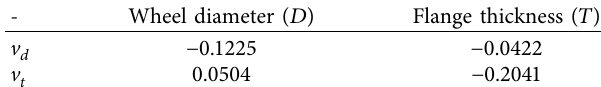
Table 1: Correlative